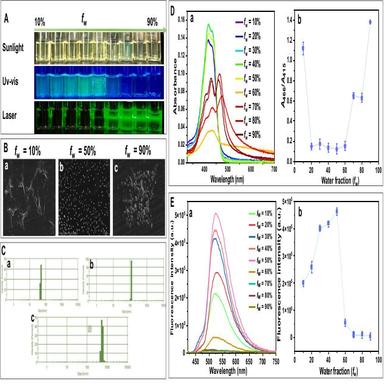
Images show AIE behavior of Z1. A. Under sunlight/Uv-vis/ laser radiation, color change of Z1 in mixed solution of different water fractions (fw)(vH2O/vEtOH = 10, 20, 30, 40, 50, 60, 70, 80, and 90 %), respectively. B. Scanning electron microscope (SEM) morphologies of probe Z1 in different solvent mixtures of fw = 10 % (a), fw = 50 % (b) and fw = 90 % (c), respectively. Scale bar: 100 nm. C. Particle size distribution of Z1 in different solvent mixtures of fw = 10 % (a), fw = 50 % (b) and fw = 90 % (c), r